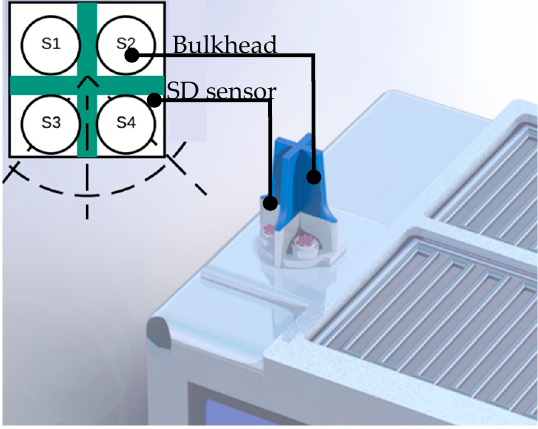
Figure 6. Arrangement of sensors based on the shading pattern.